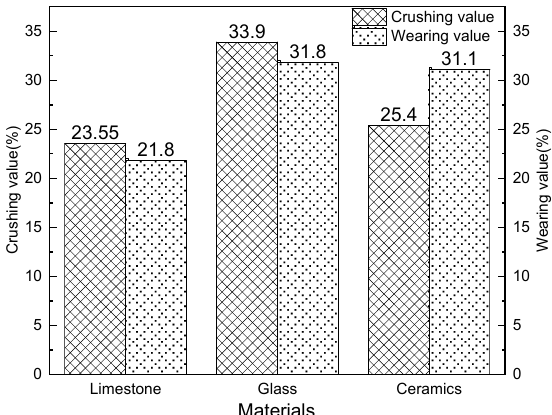
Figure 6. Test machines.